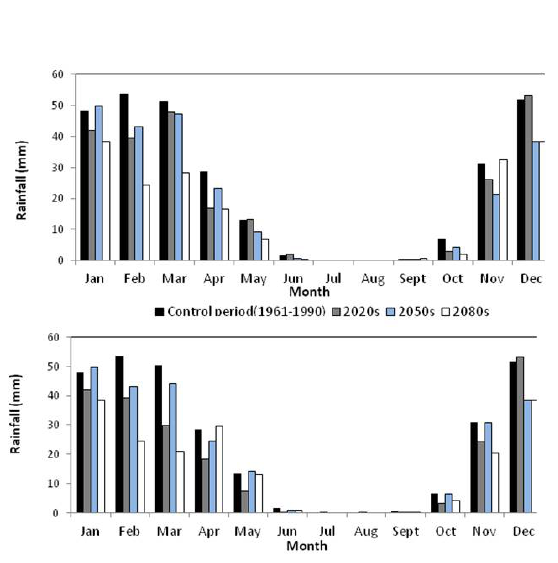
Figure 11. Average annual rainfall for A2 scenario (upper) and B2 scenario (lower) compared with control period. Linear trendindicatesthatthereisasignificantdownwardtrend.